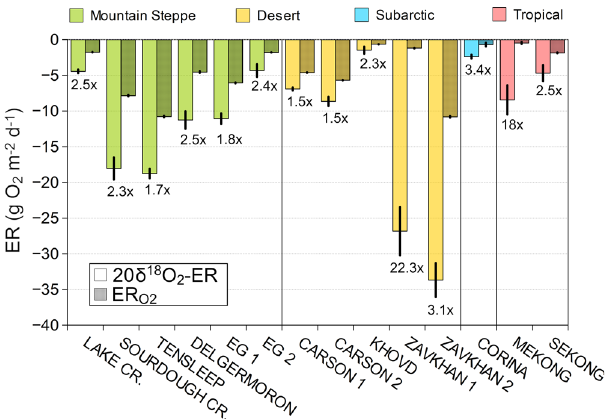
Fig. 4 Temperature normalized (20 °C) diel rates of ecosystem respiration (20 δ 18 O 2 -ER) from dual δ 18 O 2 and O 2 model compared to diel ER O2 rates from O 2 – only model. 20 δ 18 O 2 -ER rates from dual δ 18 O 2 and O 2 model (solid bars) compared to ER O2 (patterned bars) estimated with O 2 - only metabolism models that assume ER is constant over 24-h. Labels indicate the magnitude of the difference between 20 δ 18 O 2 -ER and ER O2 for each site. Black bars indicate ±1 SD of posterior model estimates.